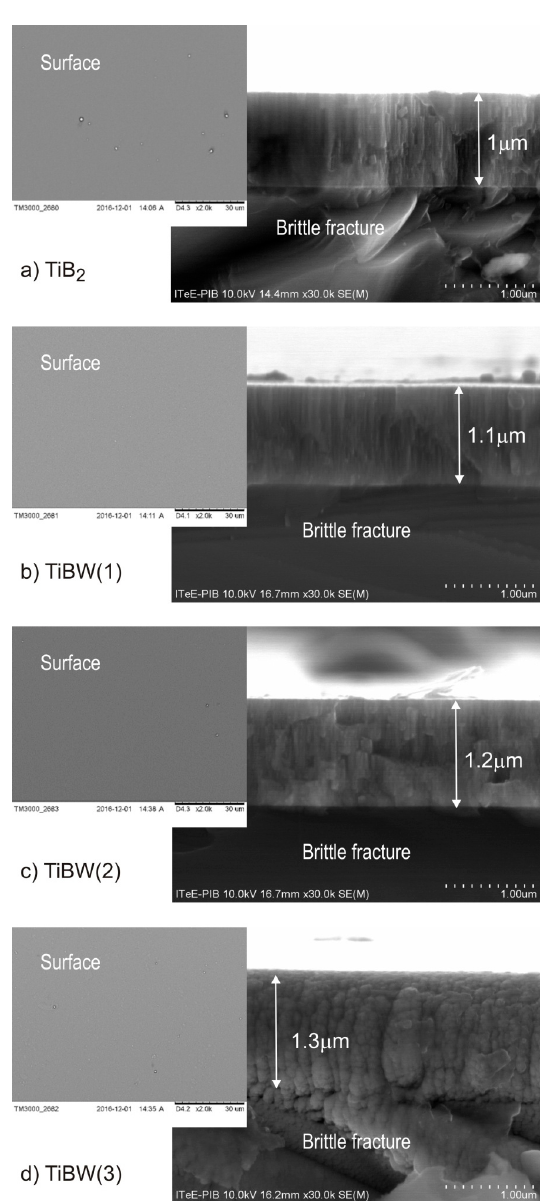
Figure 3. SEM micrographs from the surface (on the left section) and from the brittle fracture cross-section (on the right section) with coating thickness measurements for coatings obtained with different power of tungsten sputtering ( P W in Table 1): ( a ) TiB 2 : P W = 0 W; ( b ) Ti-B-W(1): P W = 25 W; ( c ) Ti-B-W(2): P W = 50 W; ( d ) Ti-B-W(3): P W = 75 W.